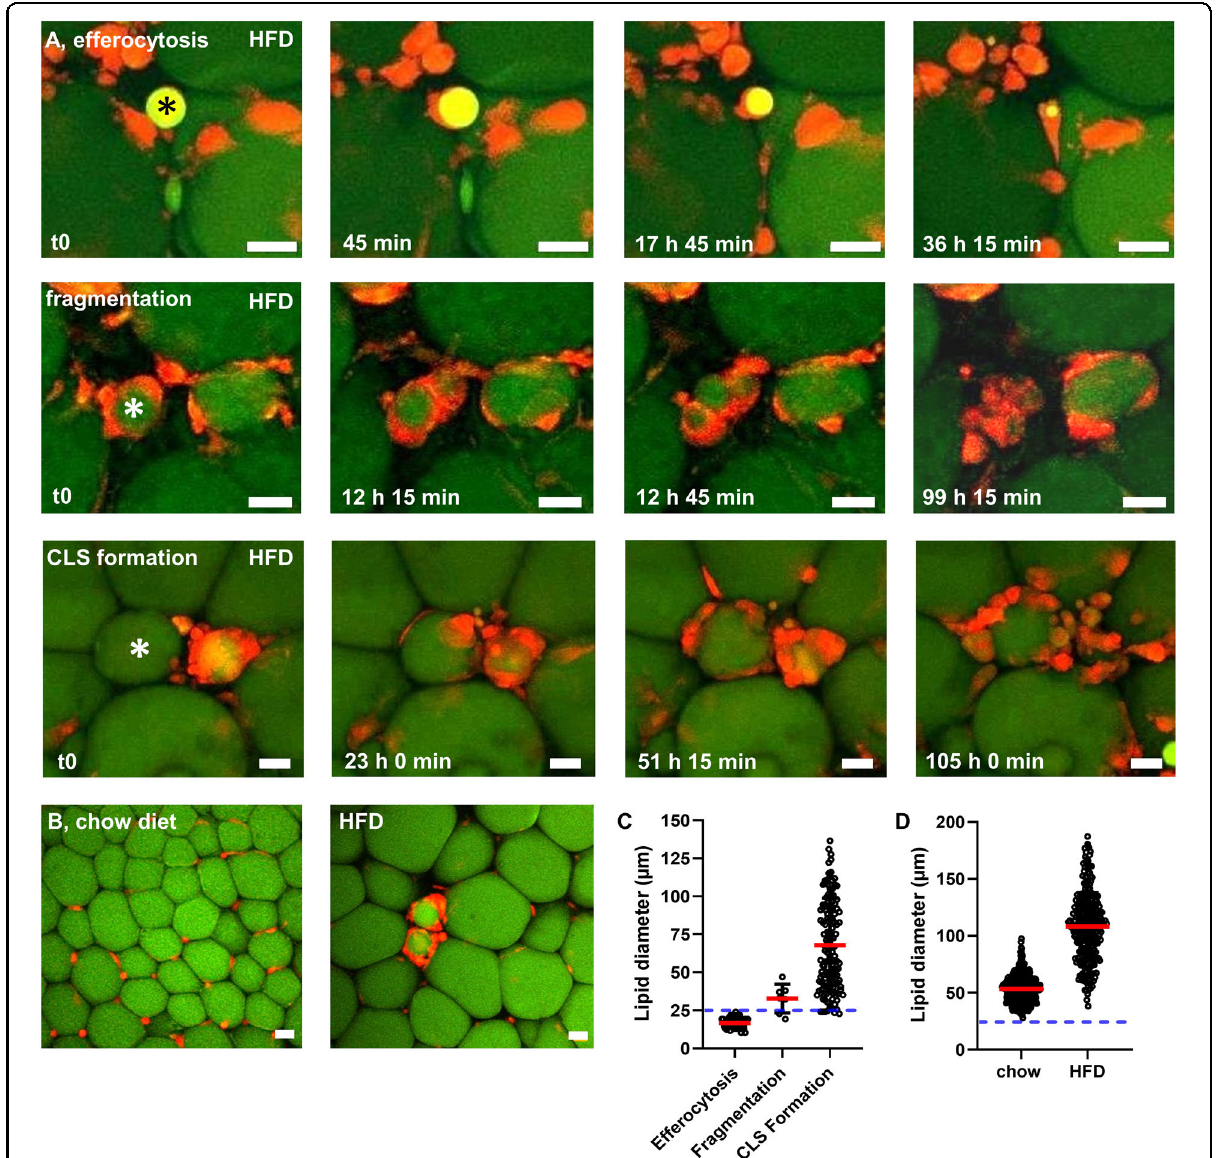
Fig. 1 Live-imaging indicates a size threshold for efferocytosis of lipid remnants. Live-imaging of AT explants of HFD-fed MacGreen mice (green: BODIPY-stained lipids, red: ATMs, movies provided as online supplement). A Degradation of adipocyte remnants in AT explants occurs in three distinct ways: efferocytosis (upper row), fragmentation (middle row), or CLS formation (lower row). B Representative overview images of living AT of chow-fed and HFD-fed mice. C Quanti fi cation of lipid diameter associated with either efferocytosis, fragmentation, or CLS formation (188 registered events in 40 movies from 6 independent experiments). D Quanti fi cation of lipid diameter in adipocytes of chow-fed or HFD-fed littermates ( N = 3). Asterisks mark lipid remnants degraded by ATMs. Blue line indicates the threshold for efferocytosis. Scale bars = 25